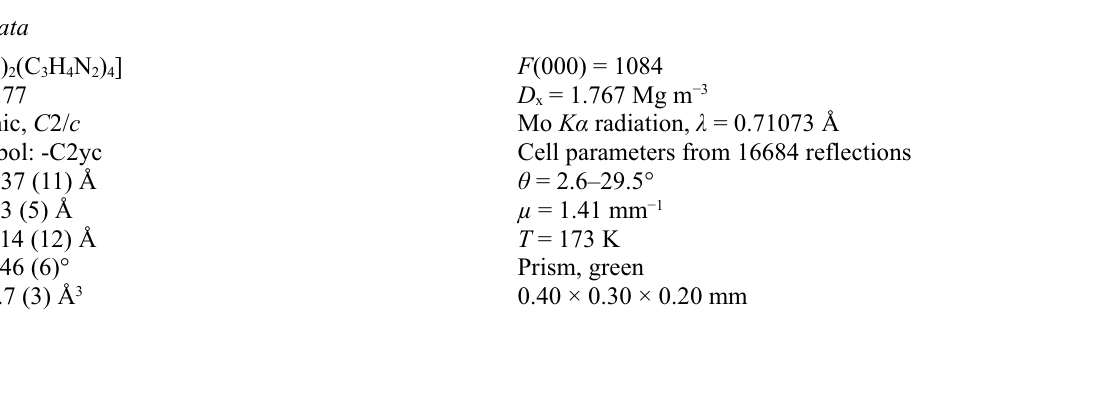
sup-2 Acta Cryst. (2008). E 64 , m1315